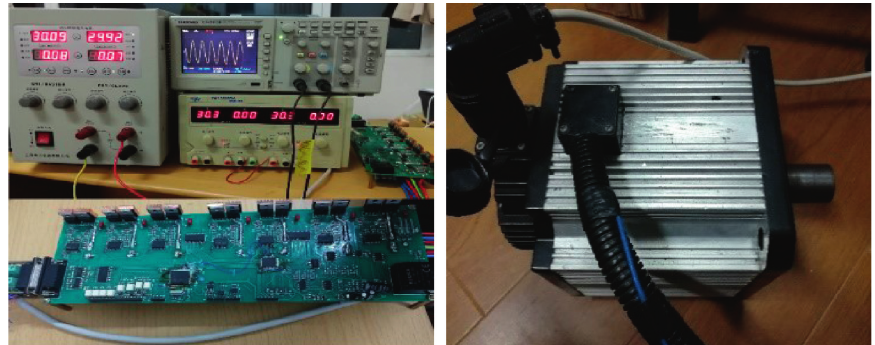
Figure 10: Seven-phase PMSM experiment platform.